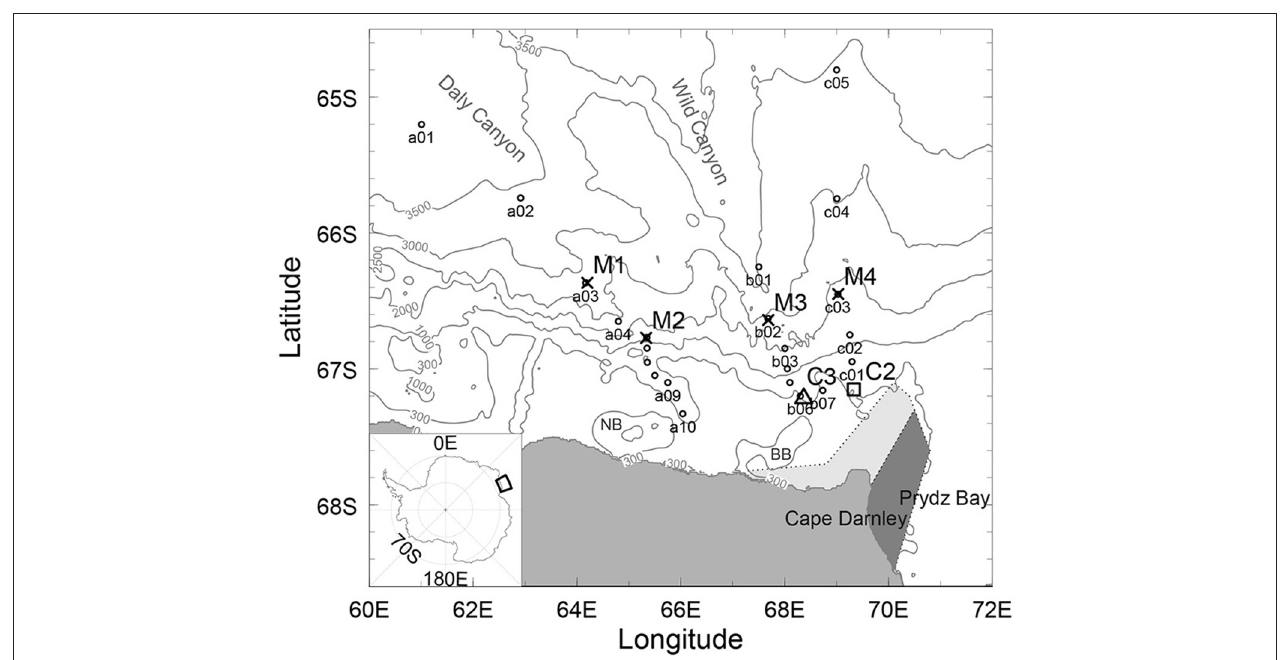
FIGURE 1 | A bathymetry map of the study area (International Bathymetric Chart of the Southern Ocean, IBCSO: Arndt et al., 2013). Locations of moorings M1–M4 and conductivity, temperature, and depth (CTD) stations are shown by crosses and circles, respectively. The Cape Darnley polynya and grounded ice are shaded by light and dark gray, respectively. Locations of moorings C2 and C3 are shown by a square and a triangle, respectively. Transects passing stations a01–a10, b01–b07, and c01–c05 are defined as transects A, B, and C, respectively. BB and NB indicate Burton and Nielsen Basins, respectively. The thick solid line in the inset map shows the location of the study